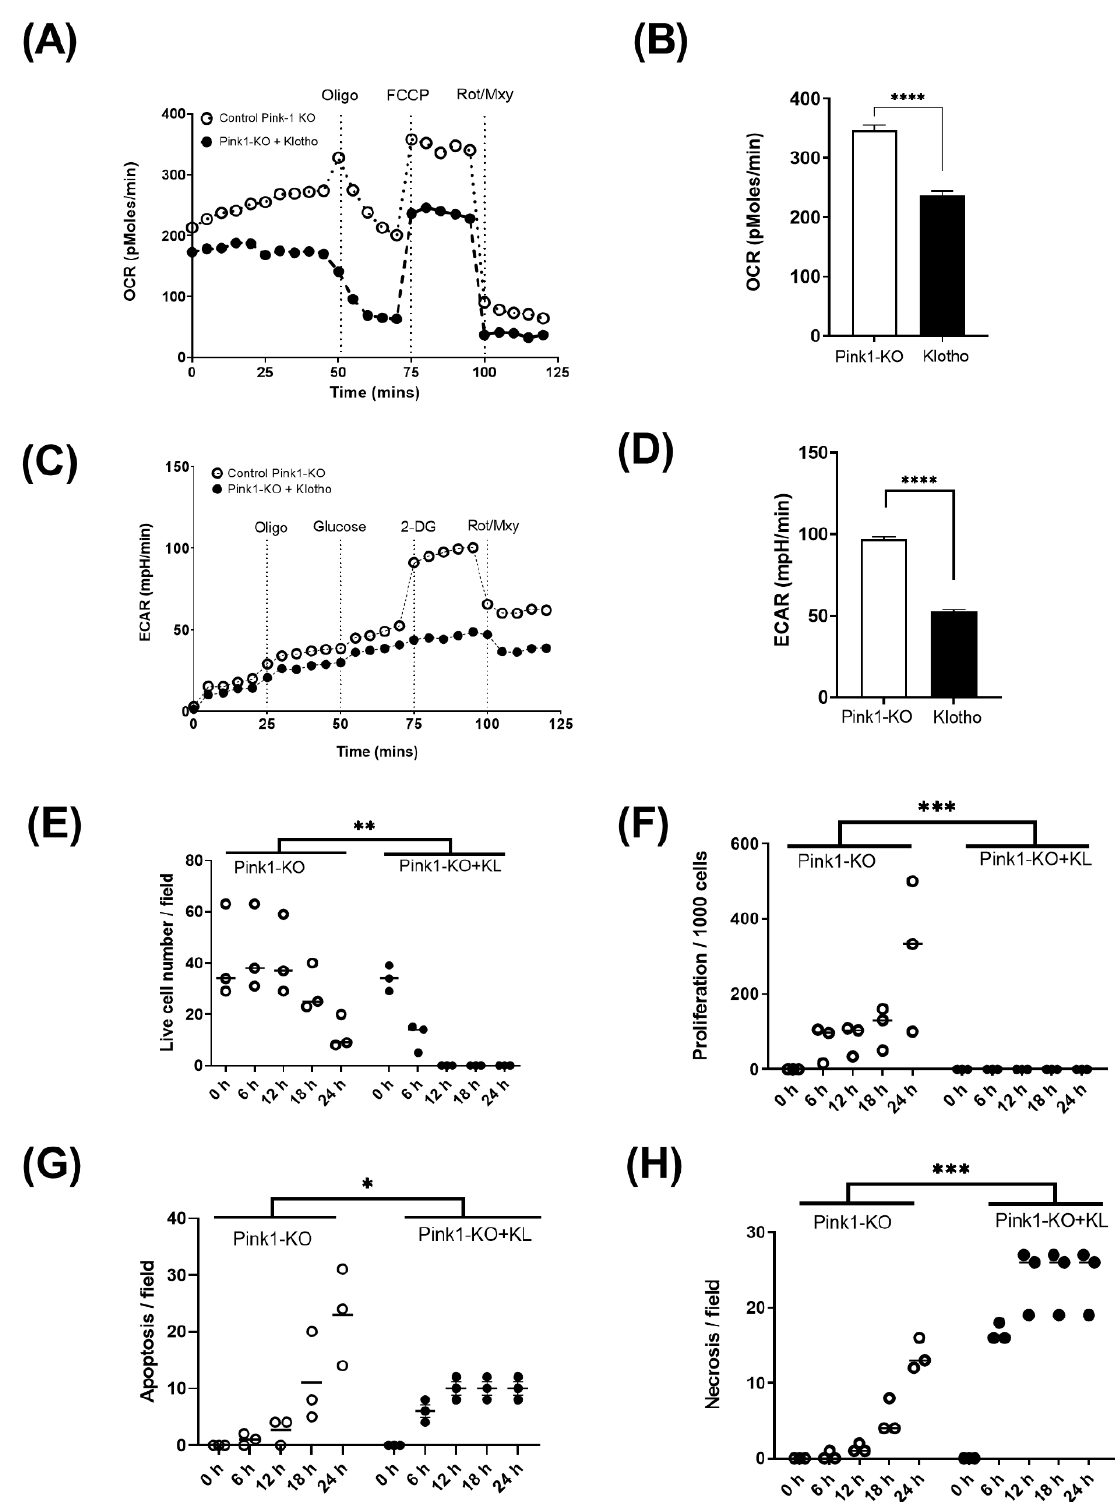
Figure 5. Pink-1 KO and Klotho energetic performance with live-cell analysis: ( A ) oxygen metabolism in Pink1-KO with Klotho; ( B ) total change in OCR; ( C ) Pink1-KO glycolytic metabolism with Klotho; ( D ) total change in ECAR; ( E ) Pink1-KO cell survival over 24 h in presence of Klotho; ( F ) Klotho-inhibited proliferation of Pink1-KO cells; ( G ) reduced apoptosis; ( H ) enhanced necrosis over 24 h. Two-way ANOVA with Bonferroni’s post hoc test ( n = 3). * p ≤ 0.05, ** p ≤ 0.01, *** p ≤ 0.001, **** p ≤ 0.0001.